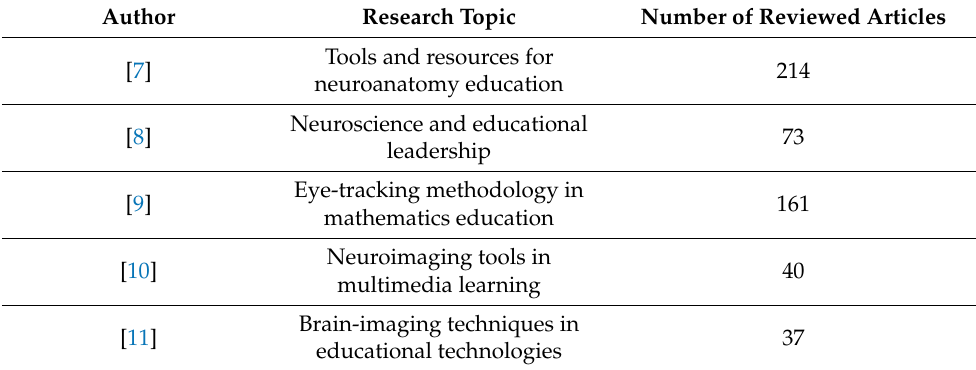
Table 1. A recent review of neuroscience in the field of